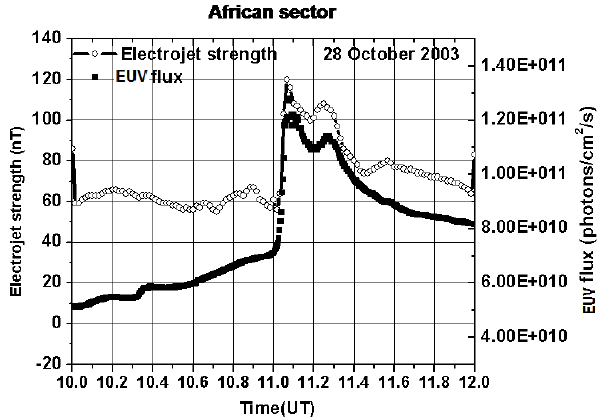
Fig. 6b. Time variation of EUV flux and electrojet strength at the station of Addis Ababa in the African sector (39 ◦ E) on 28 October 2003.